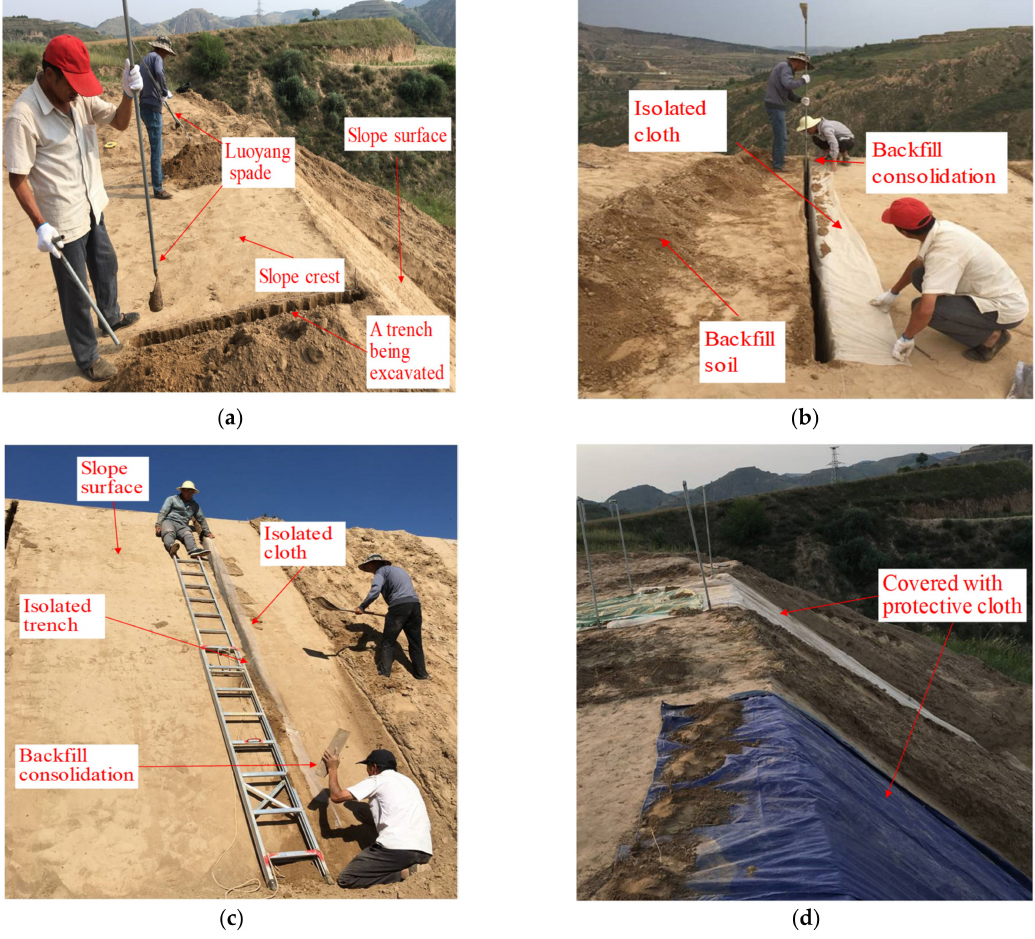
Figure 3. Construction process of isolated trench: ( a ) excavation of isolated trench; ( b ) laying isolated cloth and backfill soil at the slope crest; ( c ) laying isolated cloth and backfill soil at the slope surface; ( d ) protection after